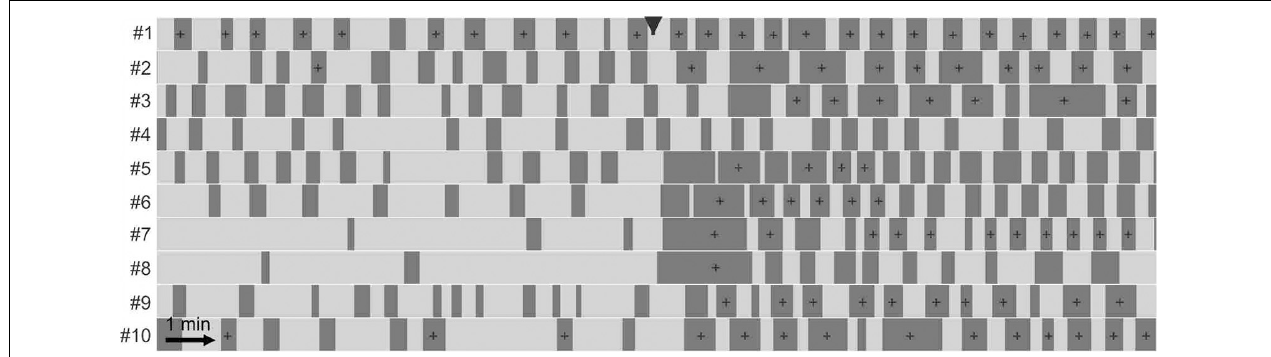
FIGURE 4 | Effect of sodium nitroprusside on cluster contractions. Effect of 1 µ M sodium nitroprusside on ten intestines shown with telegraph images (#1–#10). In each telegraph image (intestine) clusters are represented by light shading and gaps by dark shading. Nitroprusside was added at the black arrowhead. For statistical analysis see Table 1 . In the presence of SNP, the clusters occur more regular but of shorter duration.